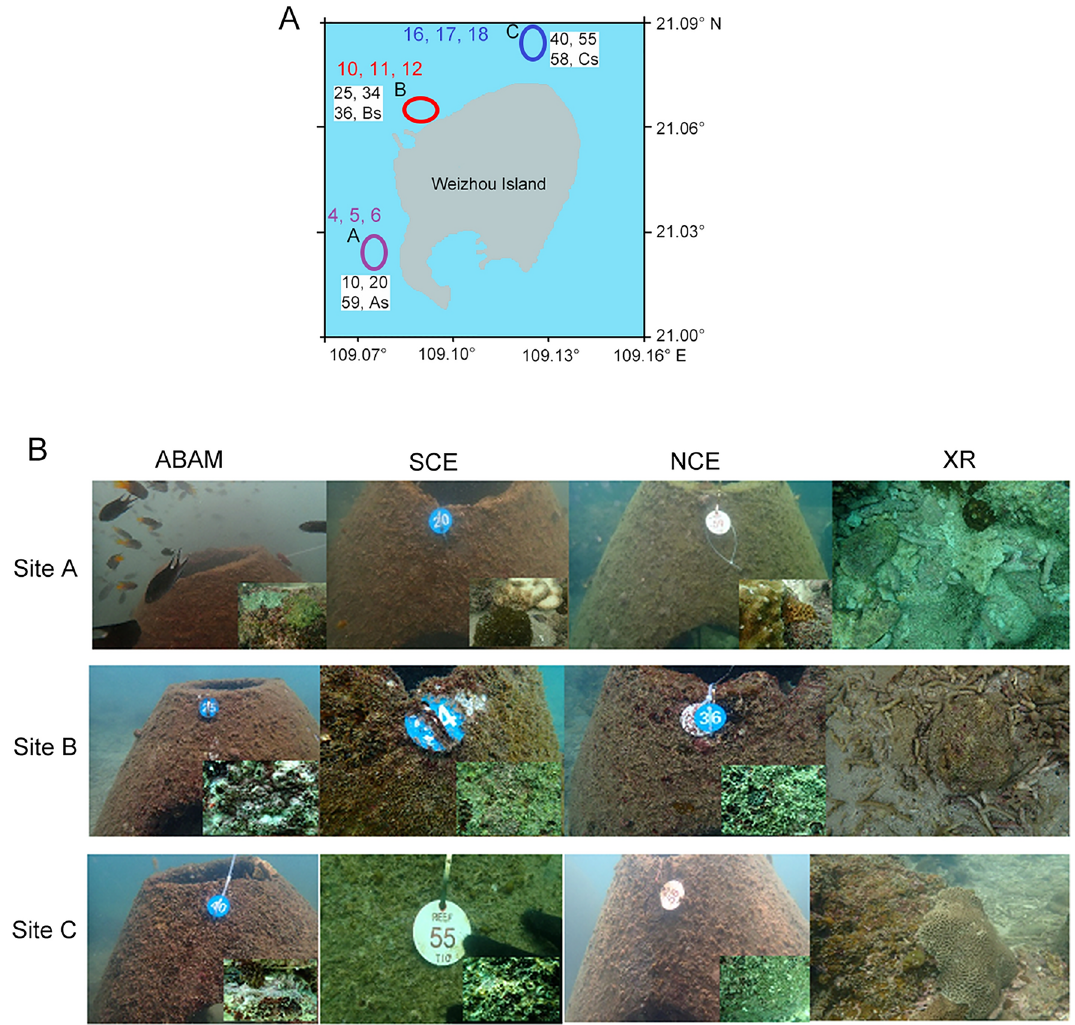
Figure 5. Co-occurrence network analysis at genus level on XR ( A ), NCE ( B ), SCE ( C ), and ABAM ( D ) group. The node colors represent different phyla as shown in the color key. The sizes of genus nodes are proportional to their relative abundance. The red and green edges represent positive and negative correlations,